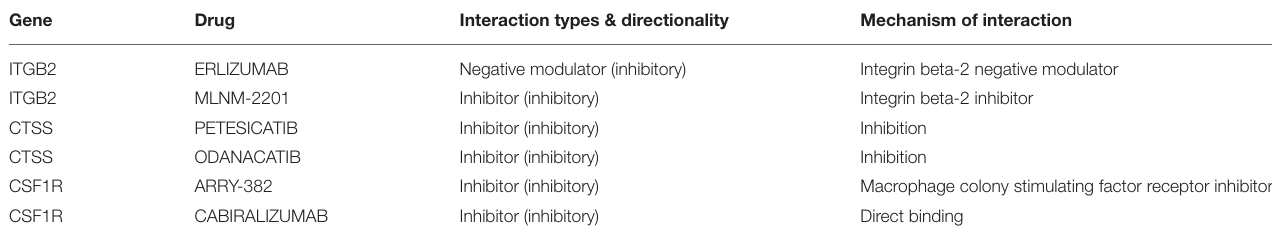
TABLE 3 | Potential druggable molecular targets for